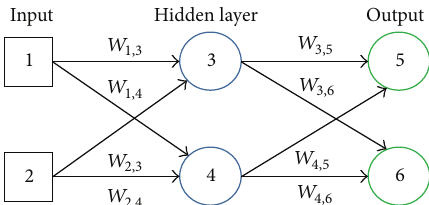
Figure 13: Single layer ANN with two inputs, two outputs, and two